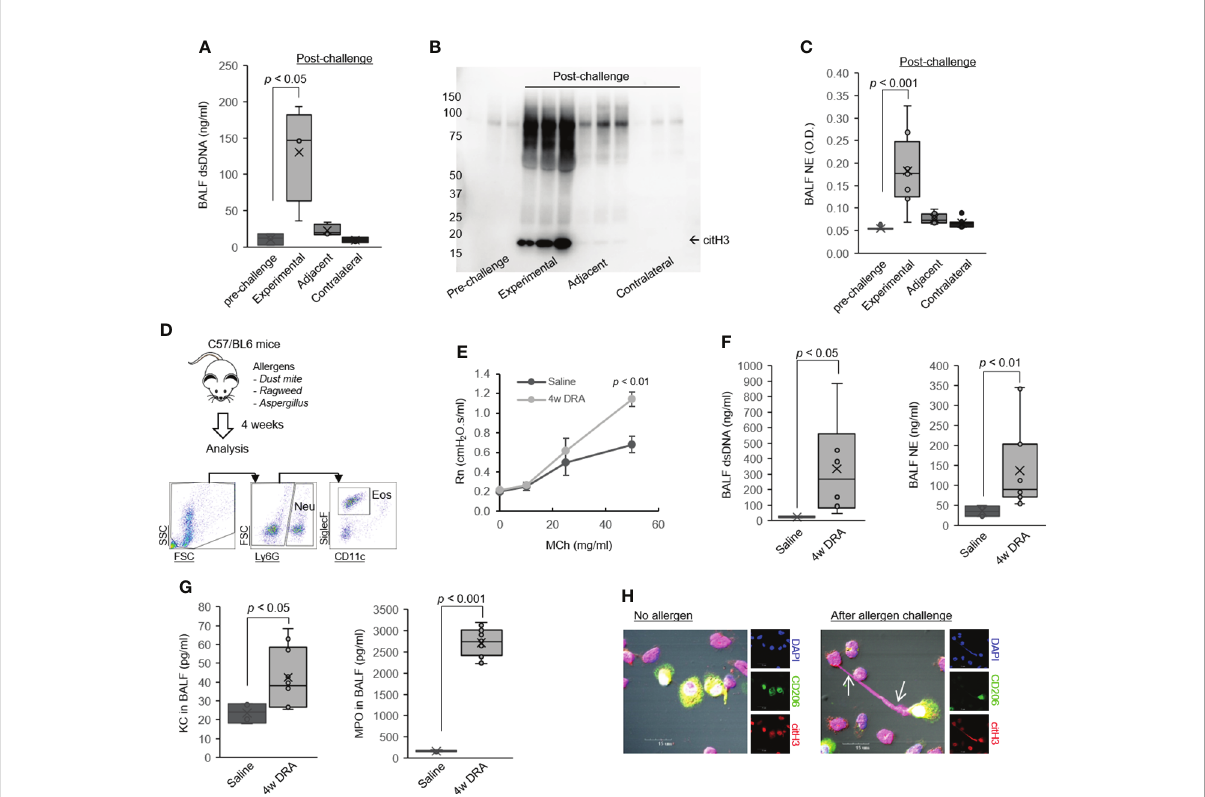
FIGURE 1 Leukocytes released ET-derived host dsDNA in asthma. (A) PicoGreen assays of extracellular dsDNA in the BALF samples obtained pre- and post- allergen challenge in the subsegmental bronchoprovocation with allergen (SBP-AG) protocol (N = 3). (B) Western immunoblot for citH3 in BALF samples obtained pre- and post – allergen challenge in the SBP-AG protocol. (C) NE from BALF in the SBP-AG protocol. (D) Mice were sensitized and challenged by daily intranasal (i.n.) administration of DRA or saline, 3 days a week for 4 weeks. Cell staining for markers of neutrophils (CD45 + Ly6G + ) and eosinophils (CD45 + Ly6G − SiglecF + CD11c − ). (E) Airway hyperresponsiveness (AHR) in mice subjected to the 4 weeks triple allergen asthma model. Shown are central airway resistance (Newtonian resistance, Rn) values. (F) Concentration of extracellular dsDNA and NE in the BALF of mice subjected to triple allergen asthma model (N = 6). (G) The level of neutrophil chemokine KC and MPO in BALF from DRA-induced asthmatic mice (N = 6). (H) Representative confocal microscopy images of lung macrophages from allergen-exposed mice producing ETs with co- expression of citH3 (arrow). Blue, staining for DNA; red, citH3; green, macrophages. Graphs were plotted as mean ± SE. p-Values were obtained using a two-tailed Student ’ s t-test. BALF, bronchoalveolar lavage fl uid; ET, extracellular trap; NE, neutrophil elastase; MPO,